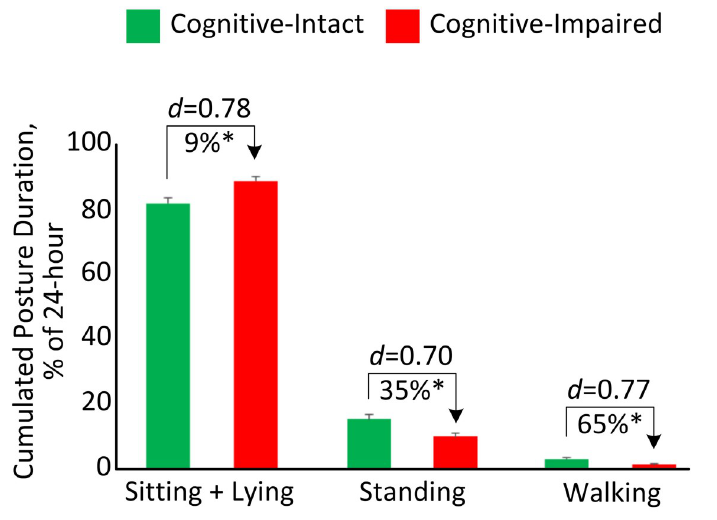
Fig 2. Cumulated posture duration (as percentage of 24-hour) for the cognitive-intact group and cognitive- impaired group. Error bar represents the standard error. “ d” denotes the Cohen’s d effect size. “ � ” denotes when the between-group comparison achieved a statistically significant level ( p <